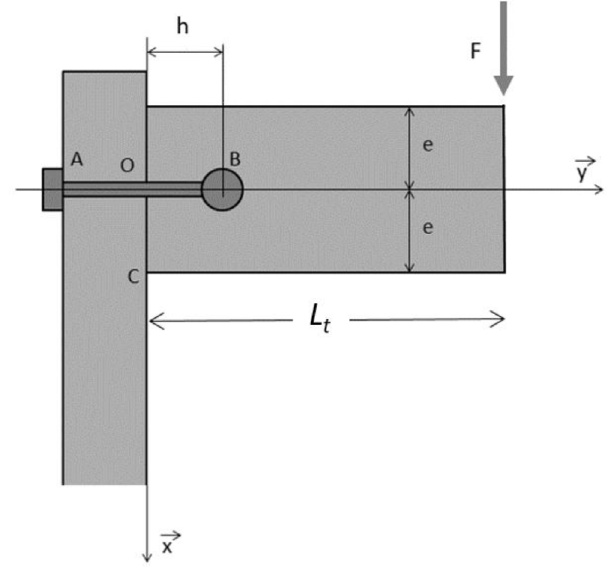
Fig. 11. One-screw assembly model for the through-bolt connection between two wooden parts of the high loft